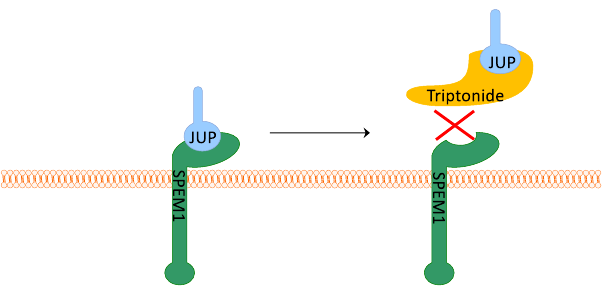
Fig. 6 The proposed action of triptonide in inducing sperm deformation and male infertility. Physiologically, SPEM1 interacts with junction plakoglobin through its N-terminus. However, triptonide binds junction plakoglobin with higher af fi nity, and this binding disrupts normal interactions between junction plakoglobin with SPEM1, causing a phenotype similar to that of Spem1 knockout, i.e., sperm deformation and